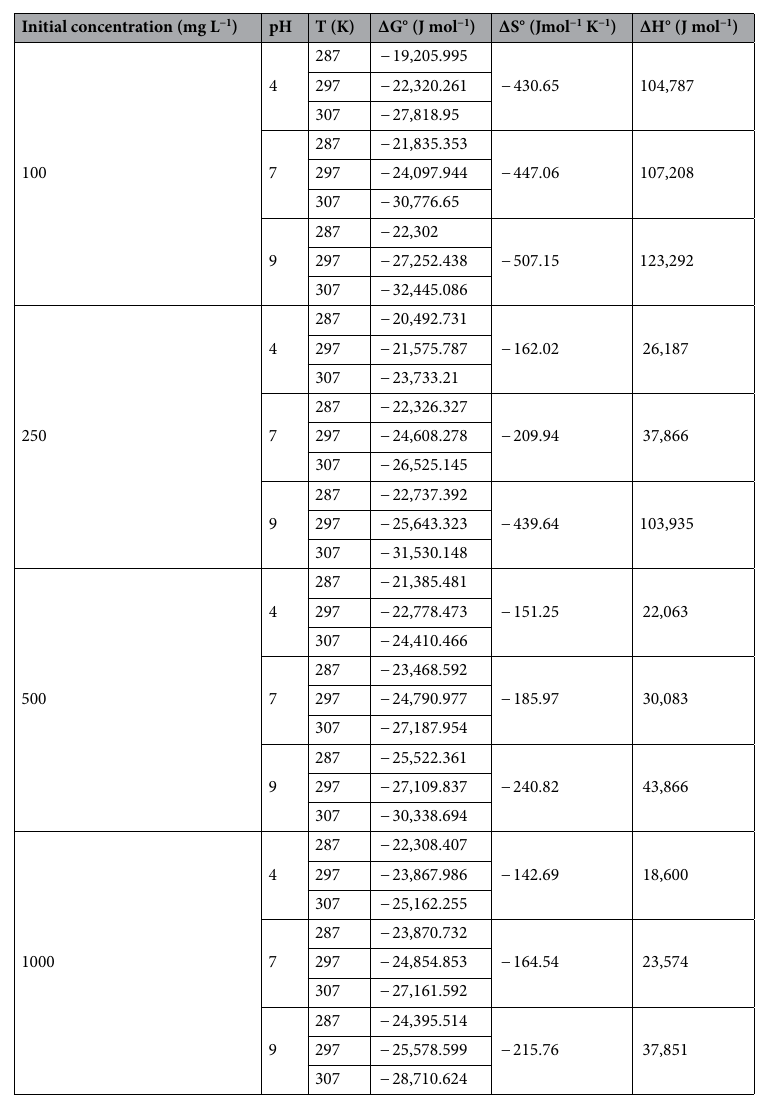
Table 3. Thermodynamic parameters for Pb (II) adsorption by nanocomposite (nMgO-bentonite) sorbent at different solution pH values (4–9) and 4 initial Pb